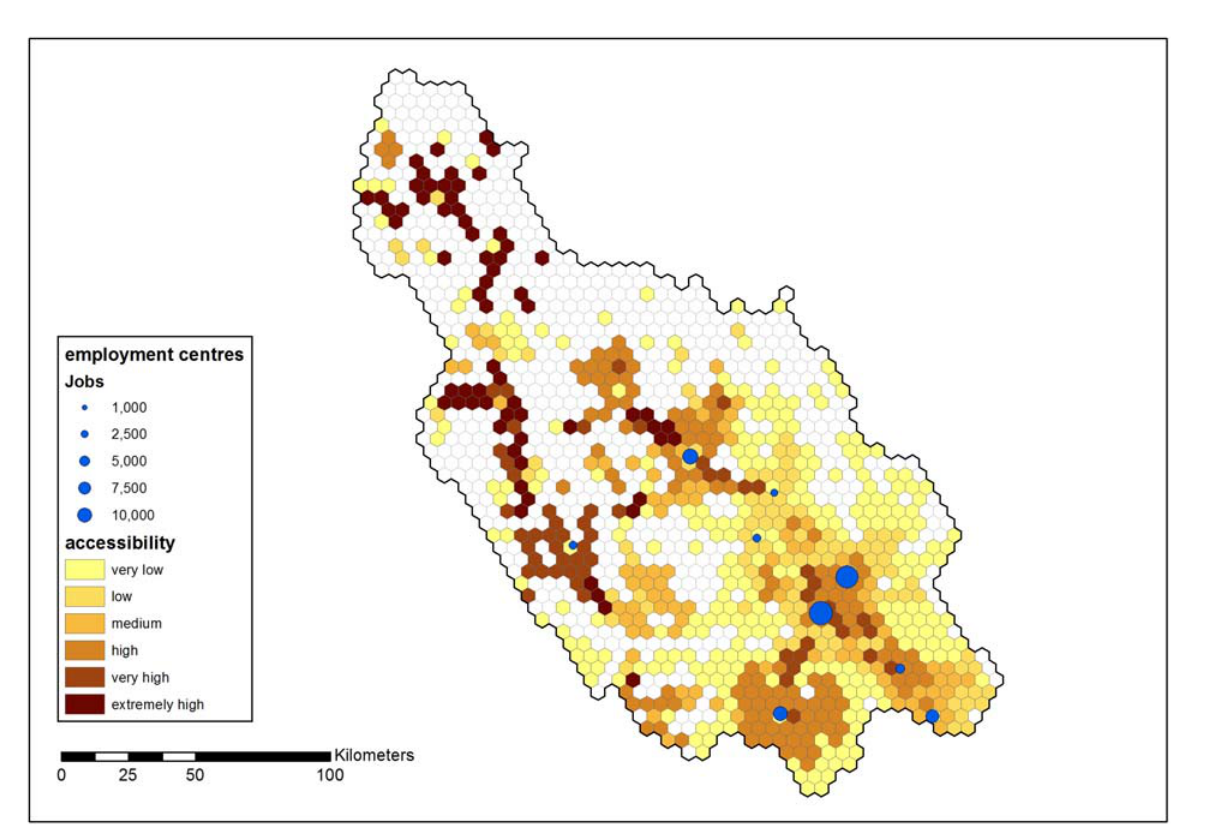
Figure 10. Network accessibility to employment (30 min travel time on road